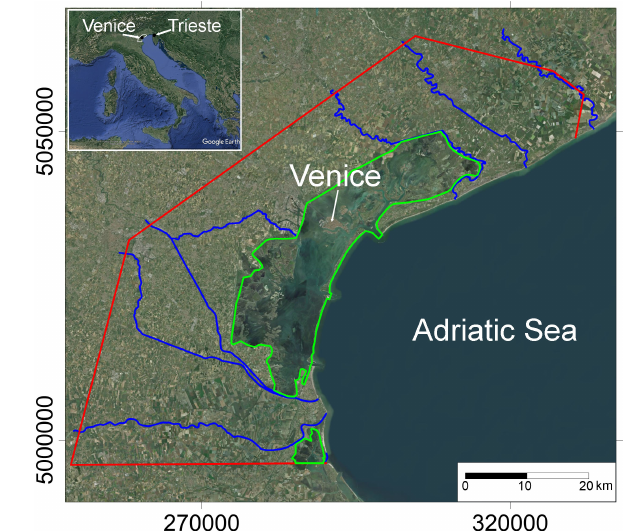
Figure 1. Satellite image of the Venice coastland facing the north- ern Adriatic Sea, Italy. Red line: boundary of the study area in the mainland; Blue lines: major rivers; Green polygons: lagoon bound- aries. Base map source: Esri, DigitalGlobe, GeoEye, Earthstar Geo- graphics, CNES/Airbus DS, USDA, USGS, Aerogrid, IGN, and the GIS User